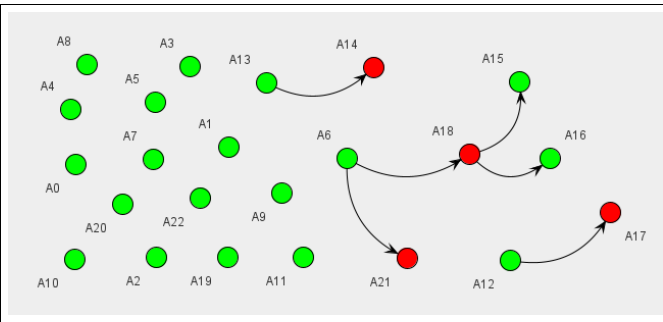
Figure 21. Graphical result of the CrossJustice